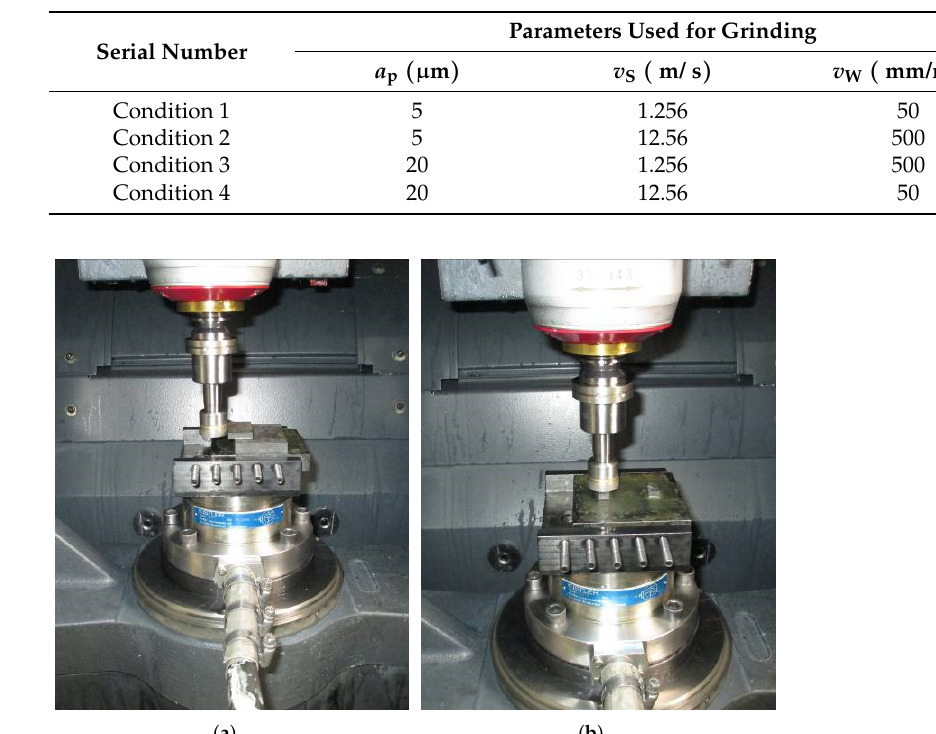
Table 5. Process parameters used to determine the empirical formula of end grinding force.